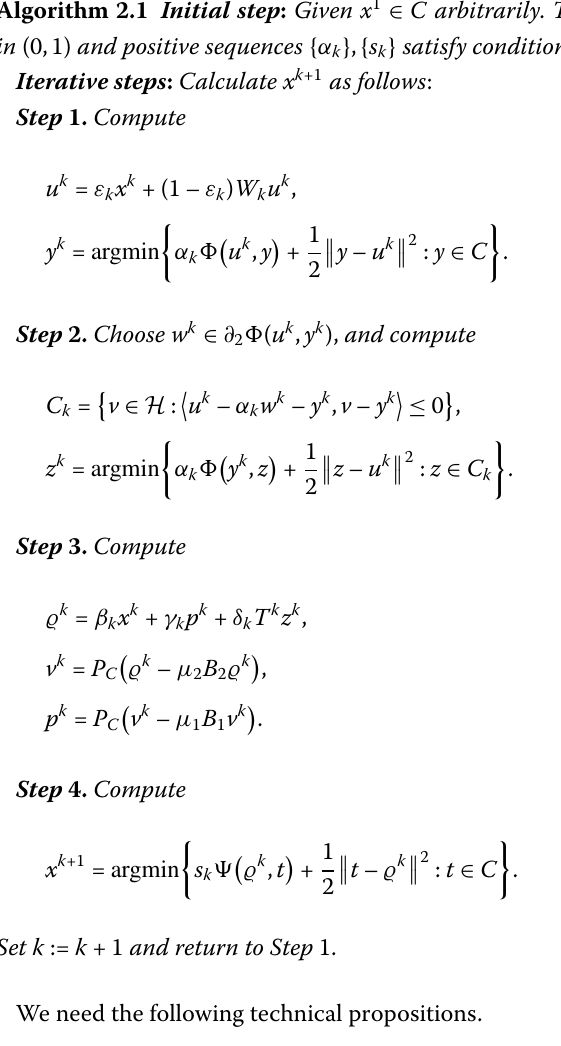
Algorithm 2.1 Initial step : Given x 1 ∈ C arbitrarily . The sequences { ε k } , { β k } , { γ k } , { δ k